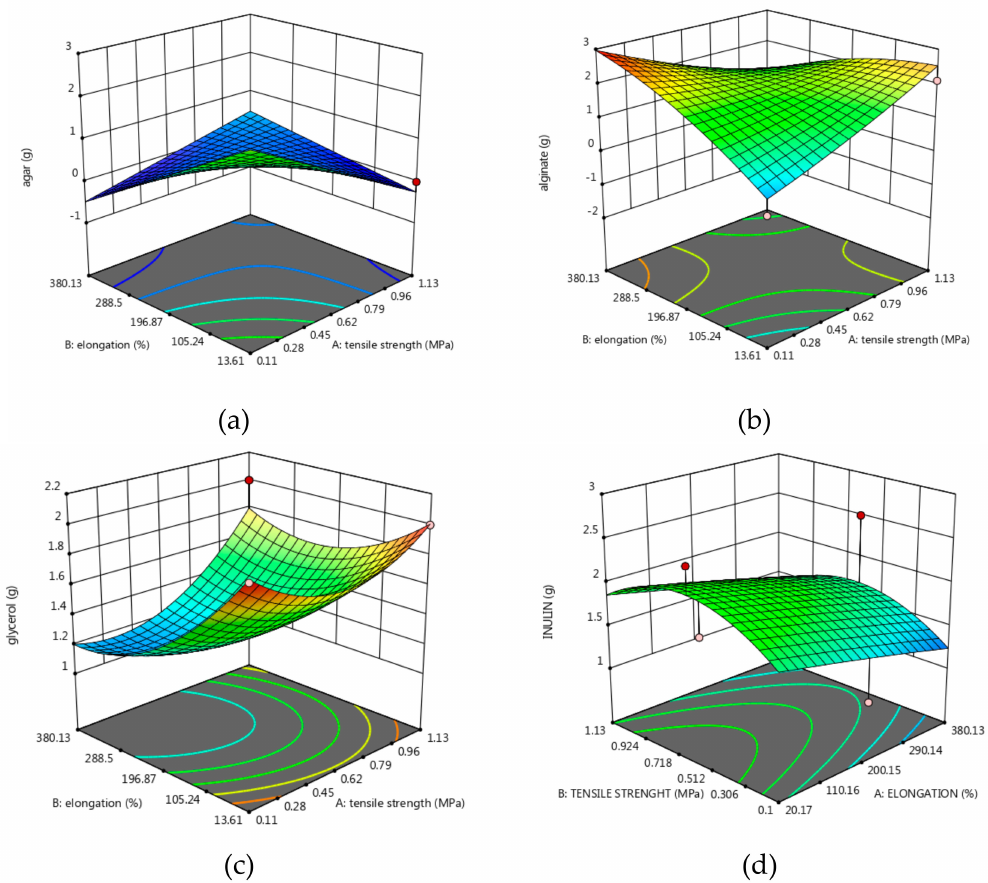
Figure 4. Optimization for a material with high strength and elasticity, but minimal roughness. ( a ) agar content, ( b ) alginate content, ( c ) glycerol content, ( d ) inulin